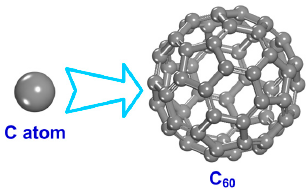
Figure 6. Molecular structure of fullerene (C 60 ).